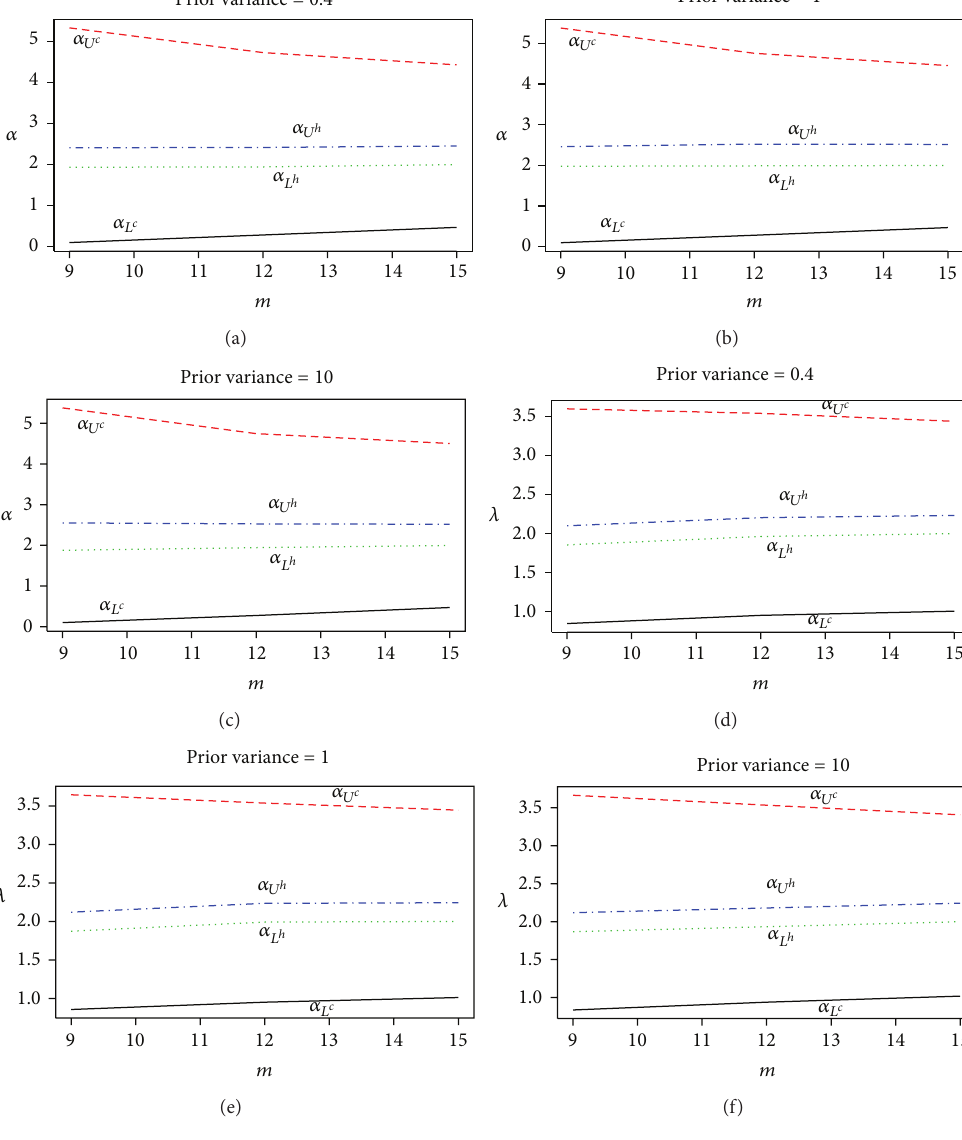
Figure 2: Average HPD and CI for different prior variances for fixed confidence coefficient.